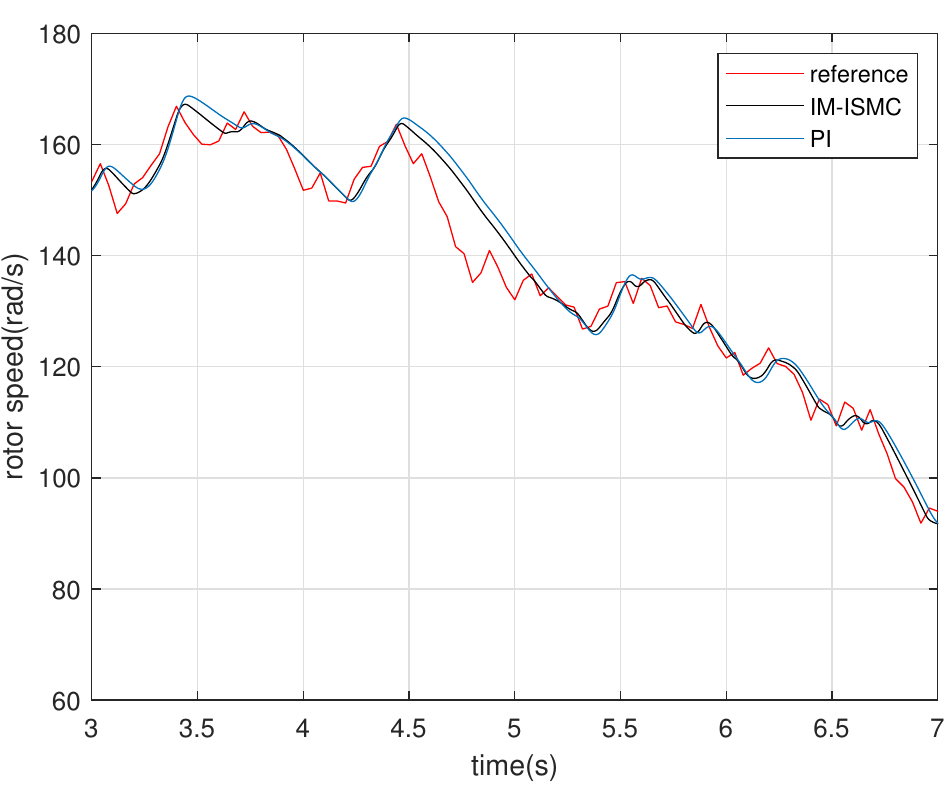
Figure 14. Rotor speed 3–7 s enlarged